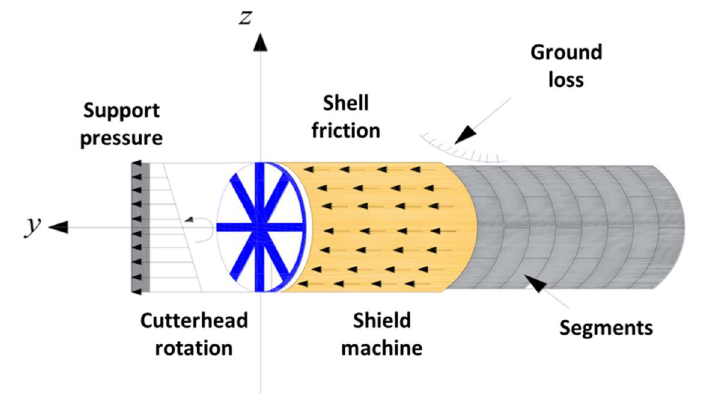
Figure 6. Interaction between the EPB shield machine and soil.